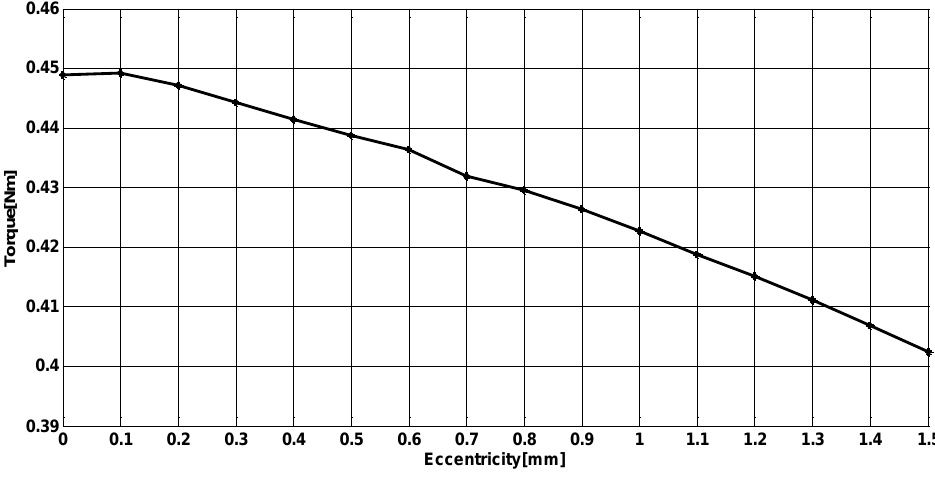
Figure 14. Torque vs. eccentricity for the best variant of ZAIM.